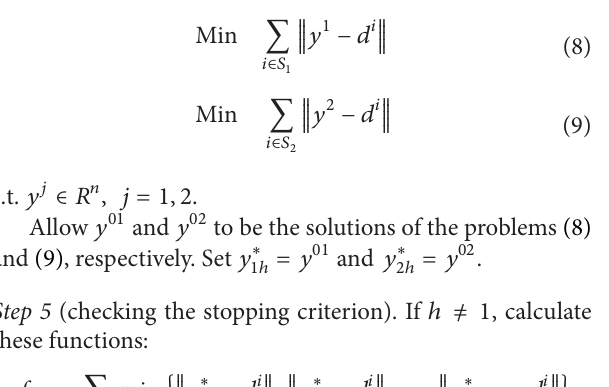
Algorithm 2. Feature